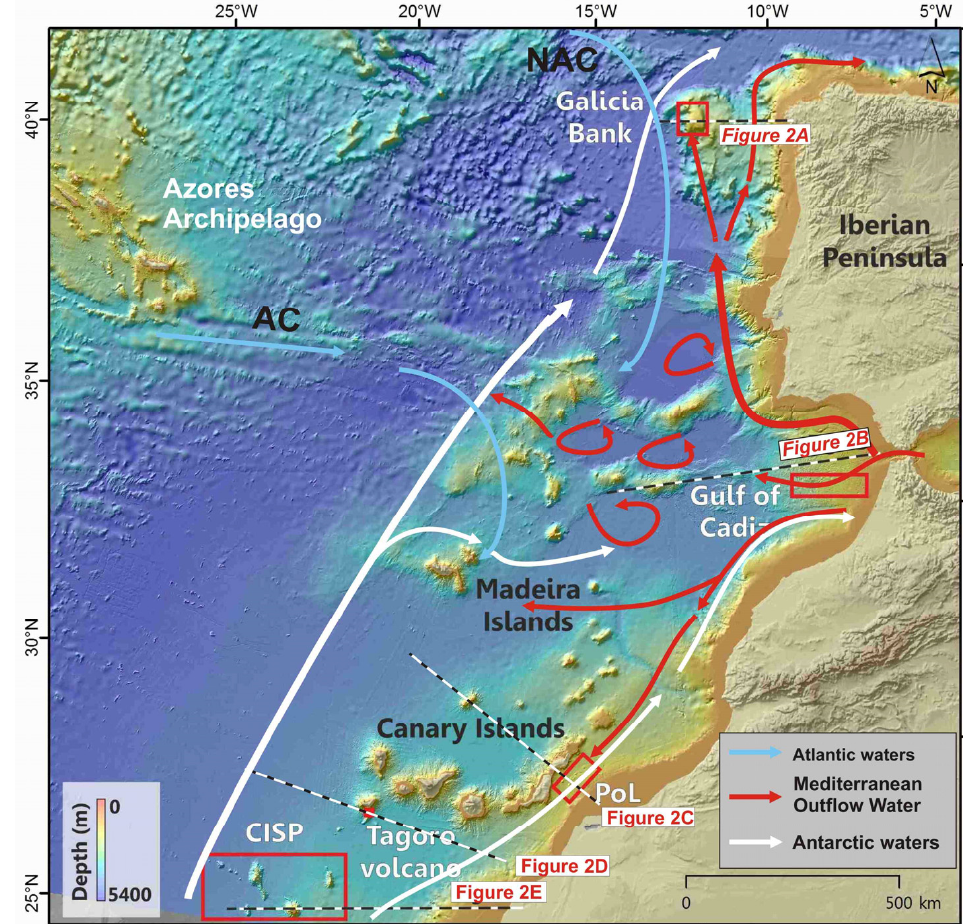
Figure 1. Location of case studies areas along the North East and Central Atlantic Ocean and sche- matic oceanographic circulation affecting the cases studies. CISP: Canary Islands Seamount Prov- ince; PoL: Passage of Lanzarote. Main currents from [8–12] are labelled as: North Atlantic Current (NAC), Azores Current (AC). Regional bathymetric map extracted from the EMODnet Project